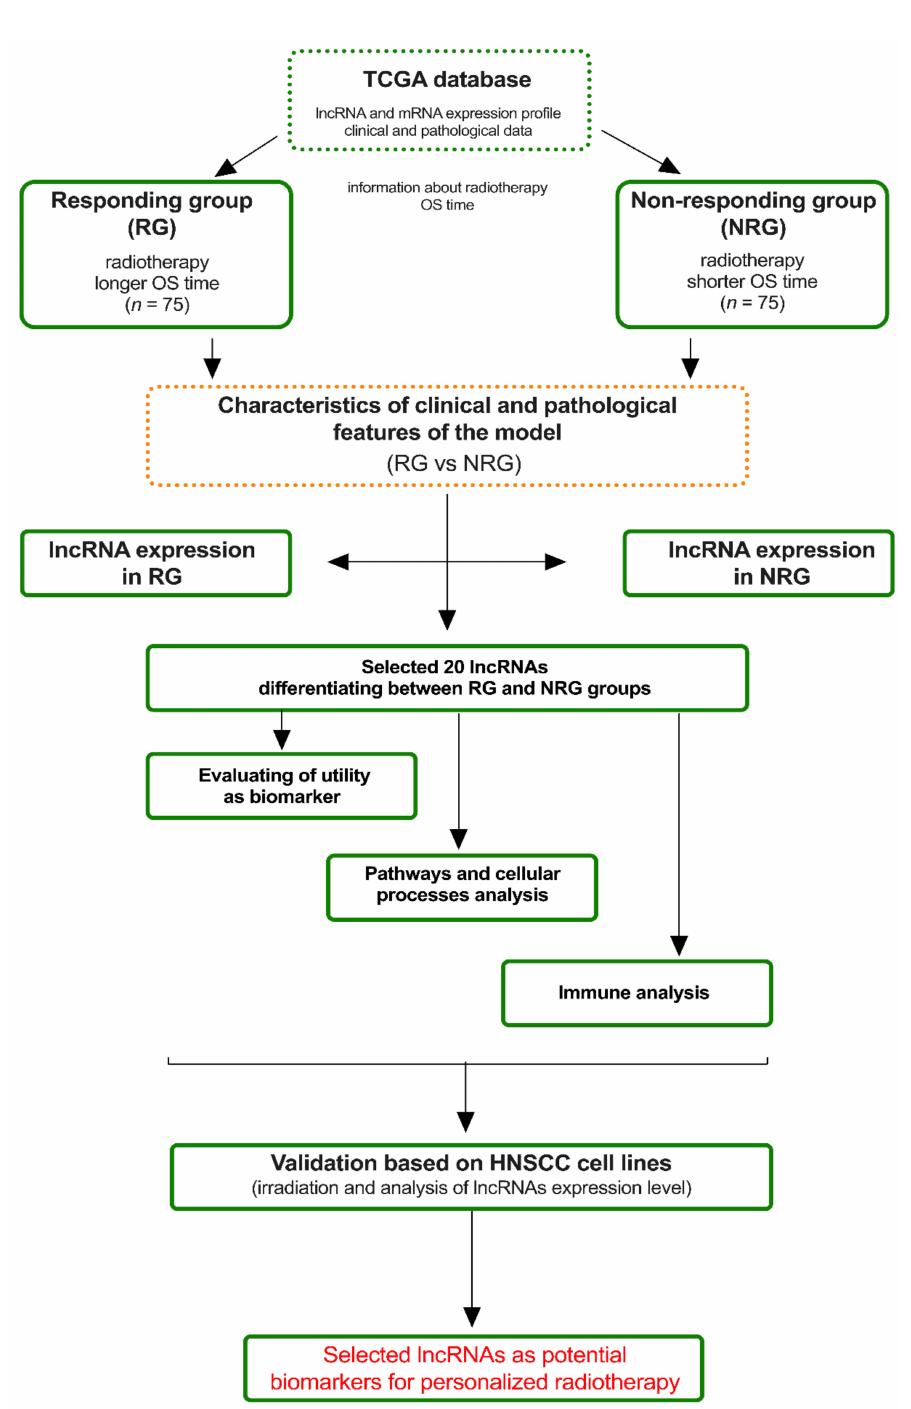
Figure 1. Overview of main experimental steps divided into in silico (based on The Cancer Genome Atlas (TCGA) analysis) and in vivo (cell lines analysis) used in this